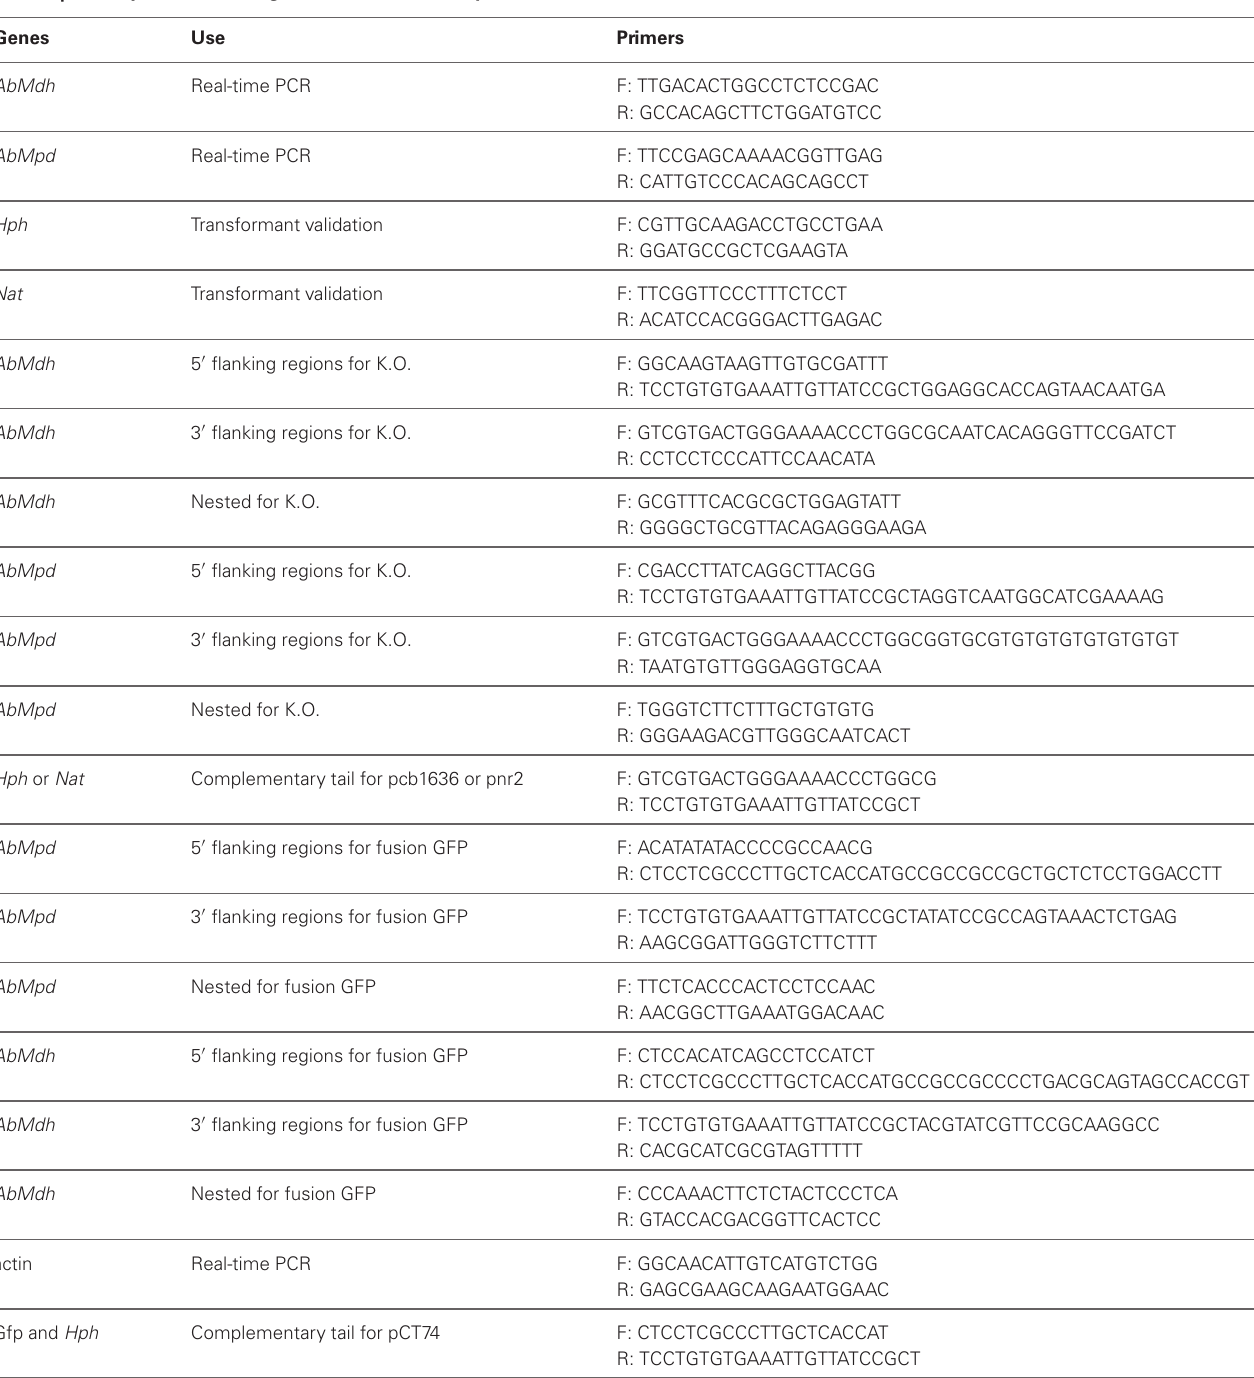
Table 1 | List of primers for the genes used in this study.